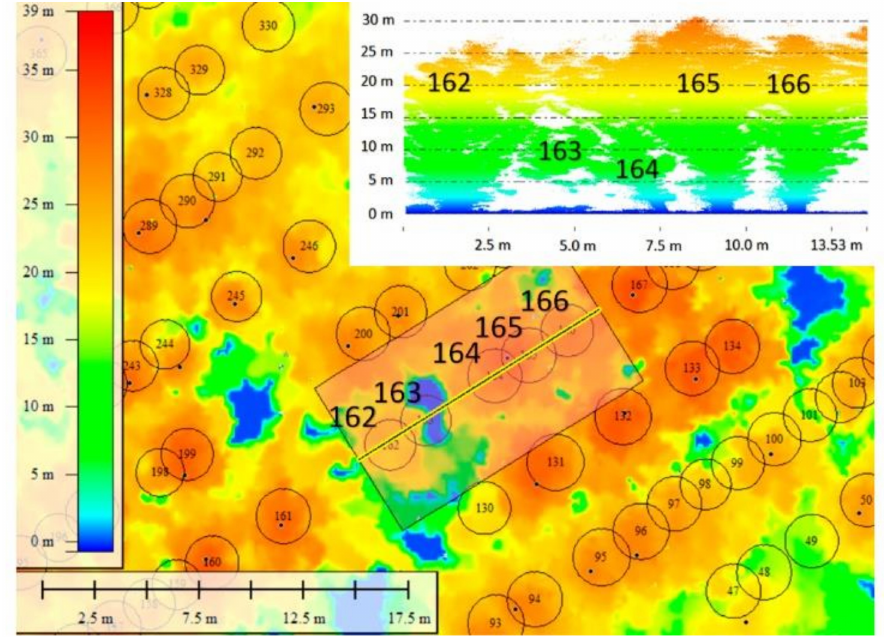
Figure 19. Nadir view of two suppressed trees in the CHM, and inset as a transect, highlighting the issue of using peak-detection for suppressed